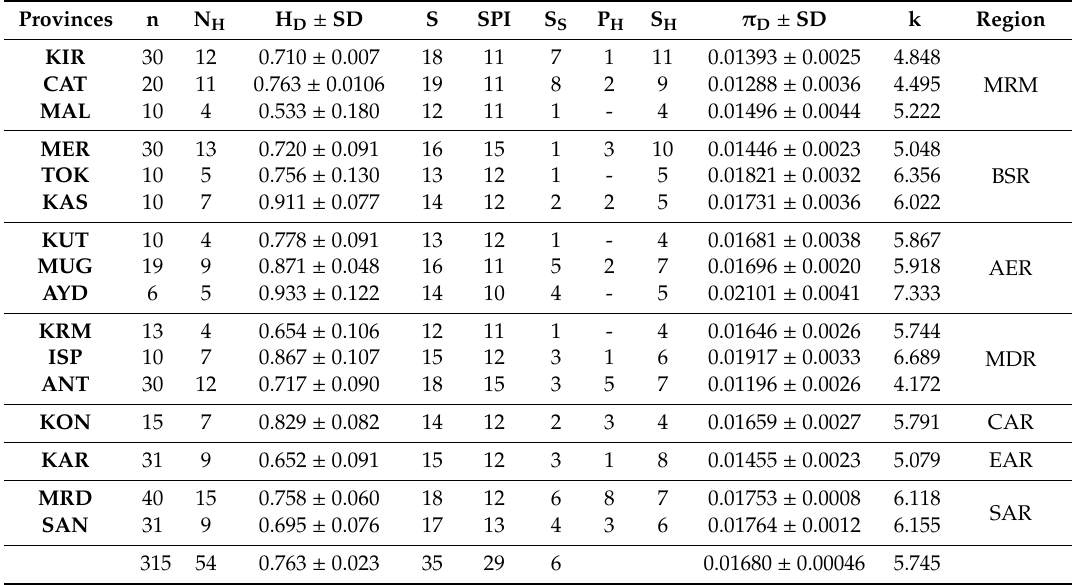
Table 2. Genetic characterization of the 16 Turkish donkey populations.